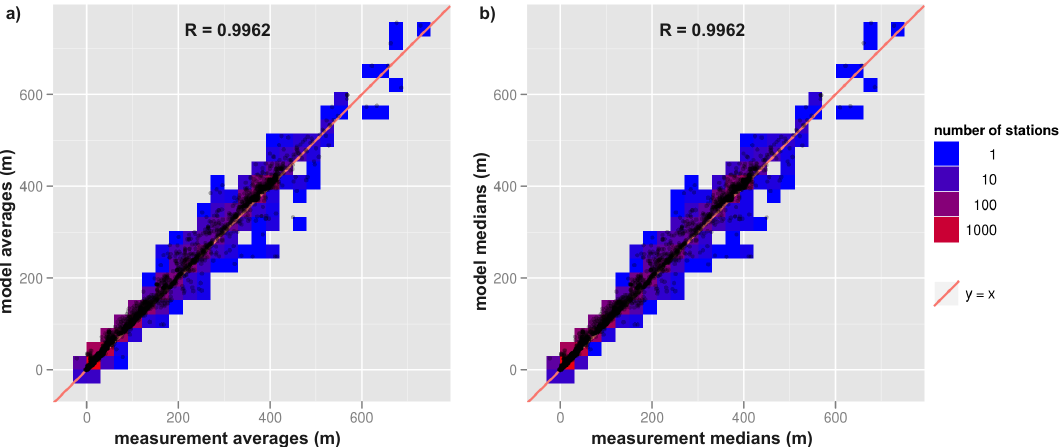
Fig. 6. The scatter-plots comparing between: (a) model result averages vs. measurement data averages; (b) model result median values vs. measurement data median values.